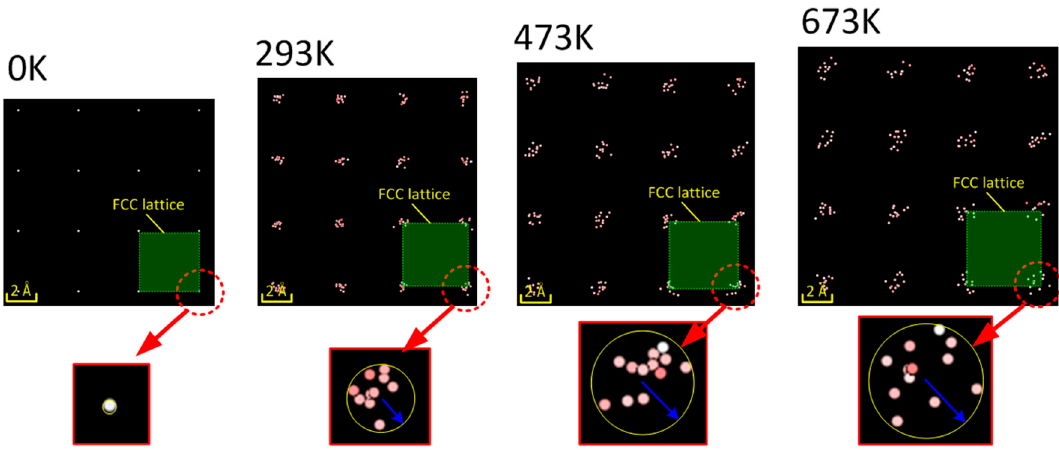
Figure 11. Atoms in the lattices of Al-Cu alloy under different temperatures.